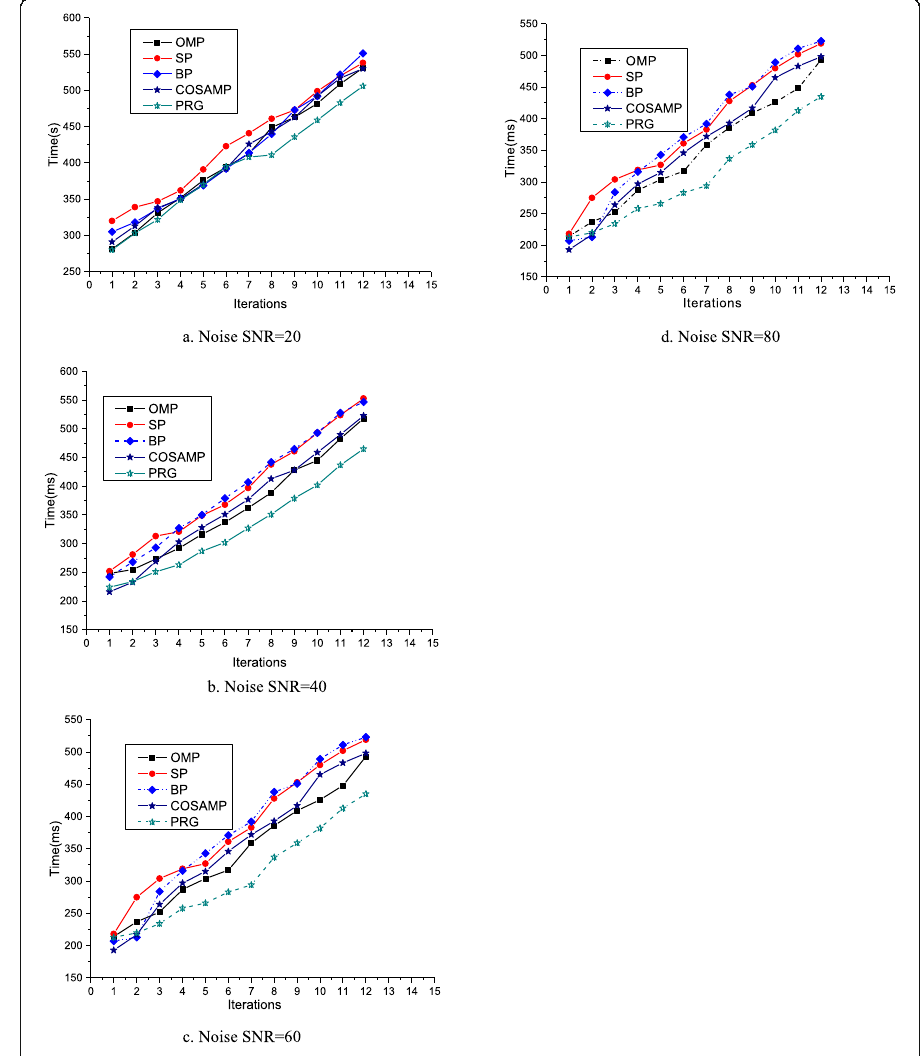
Fig. 8 Reconstruction time of heat source signals under Gaussian white